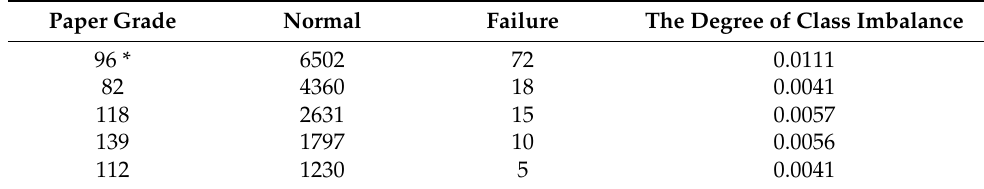
Table 2. The statistic description of original multi-sensor stream